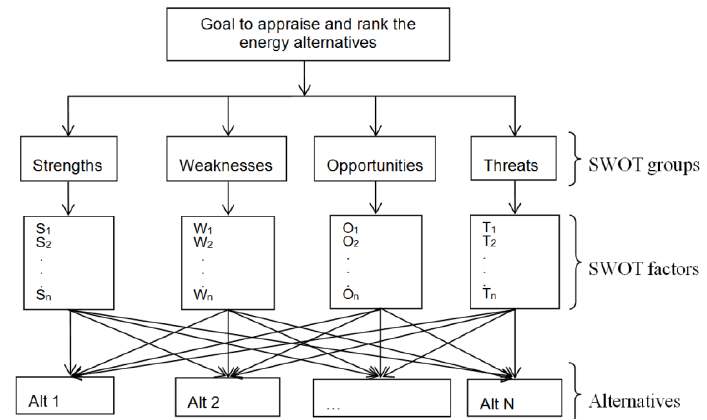
Figure 2. Hierarchical decision model (HDM). S O , …, O and T , T , …, T represents SWOT factor of each technology Alt 1, Alt 2, …, 2 n 1 2 n Alt N ,